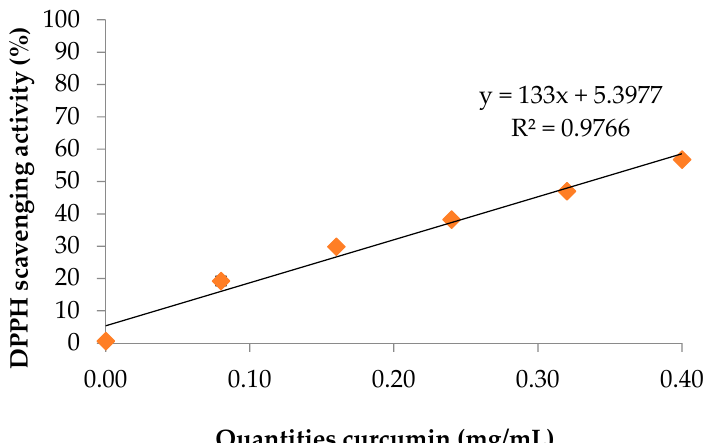
Figure 1. IC 50 of curcumin extract.